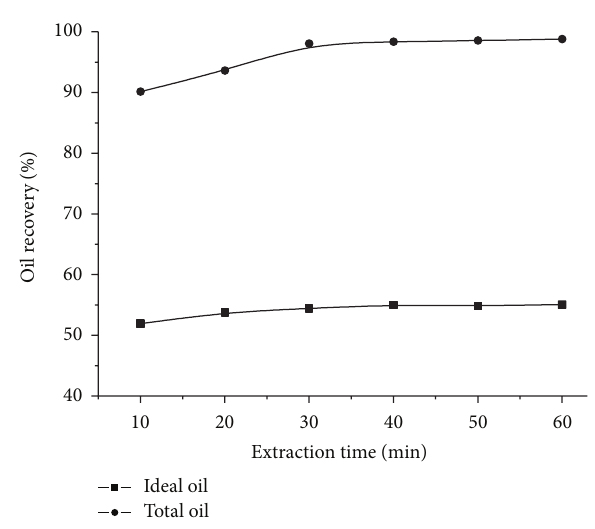
Figure 5: Effect of the extraction time.